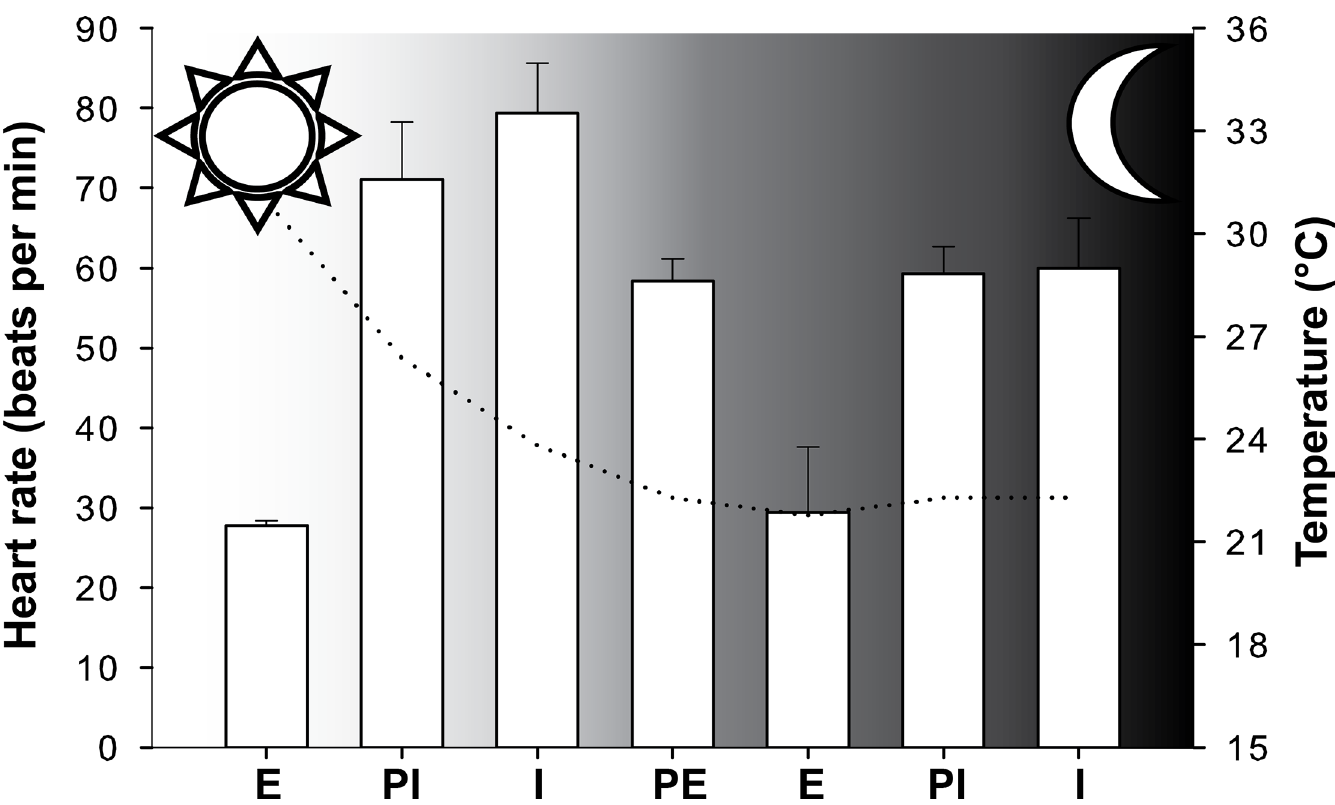
Fig 5. Heart rate variability during a complete tidal cycle measured for P . perna west individuals (average ± standard deviation, n = 4). The dotted line shows the variation in the average temperature measured during the recording. The sun and moon symbols indicate the day and night periods. E, emersion; PE, partially emersed; I, immersion; PI, partially immersed.